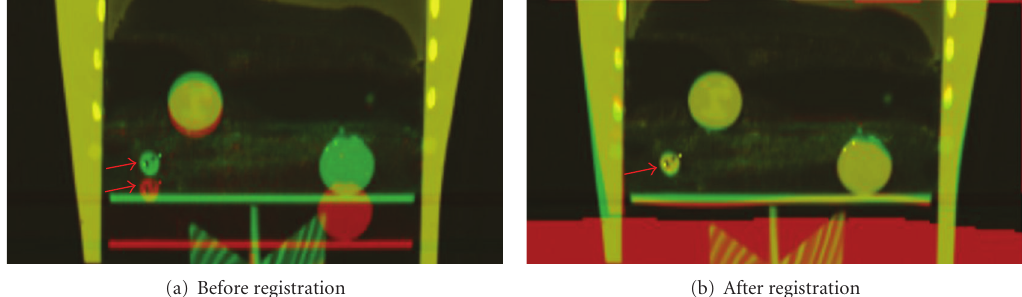
Figure 5: Fusion image between the inspiration and the expiration phase of a 3D deformable phantom.